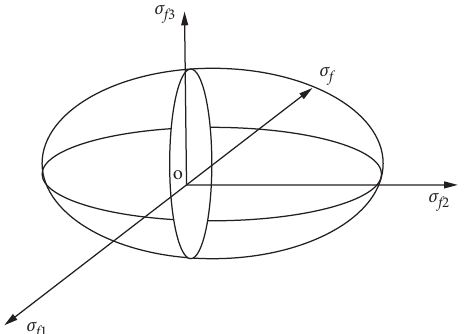
Figure 2: Illustration of the effective stress criterion (valid on σ